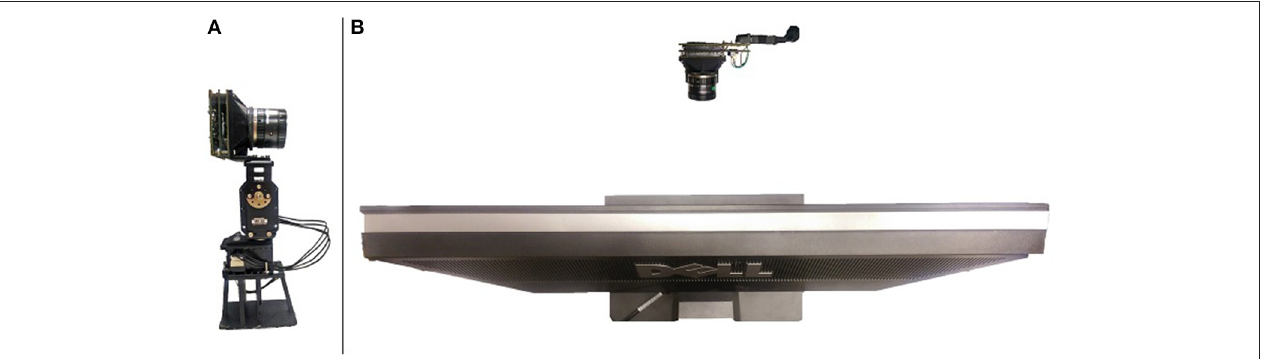
FIGURE 2 | (A) A picture of the ATIS mounted on the pan tilt unit used in the conversion system. (B) The ATIS placed viewing the LCD monitor.